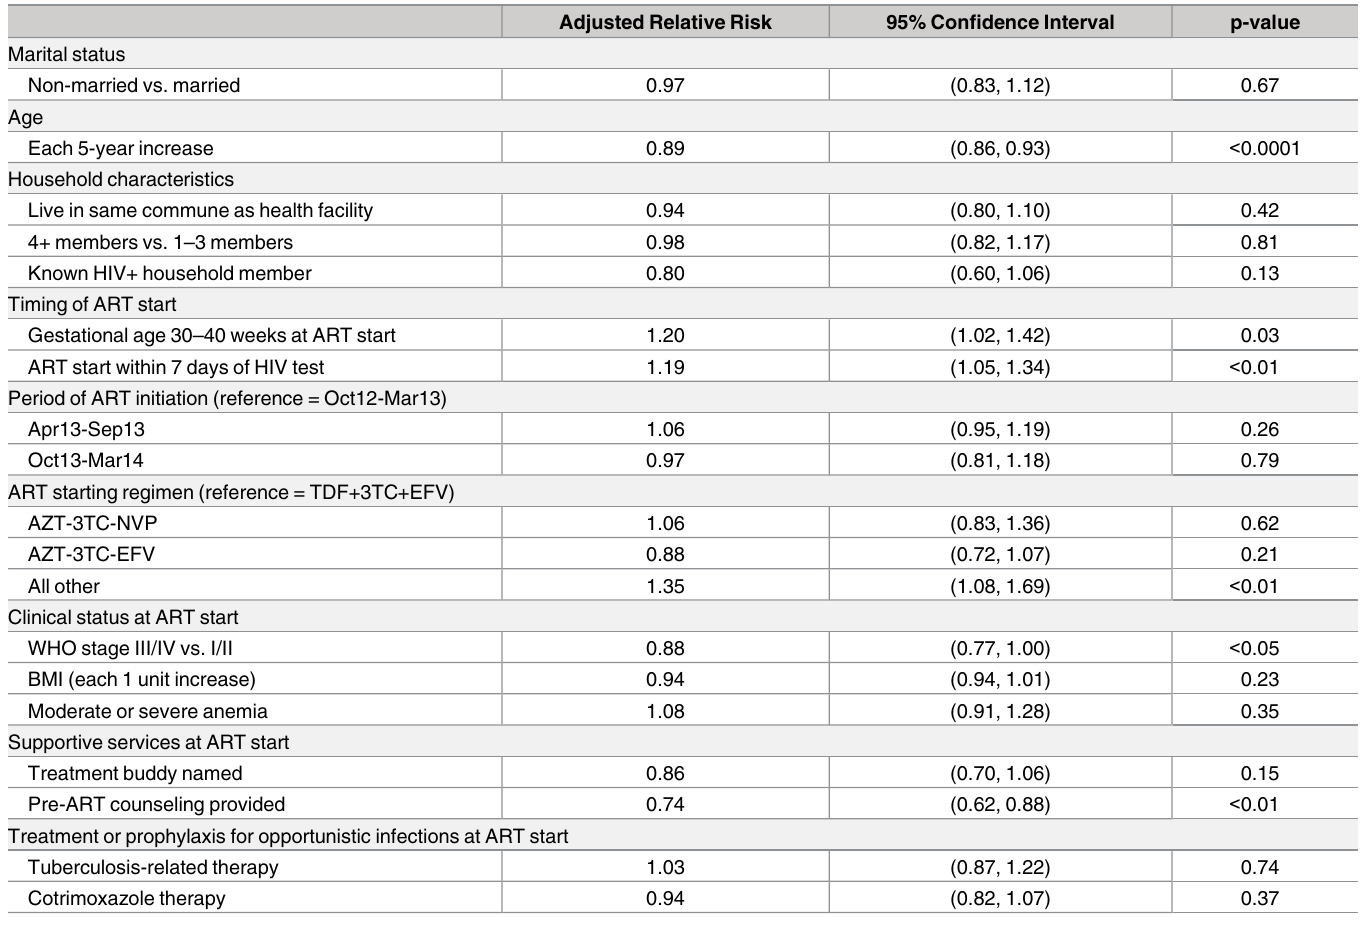
Table 3. Risk factors for ART attrition among Option B+ patients *